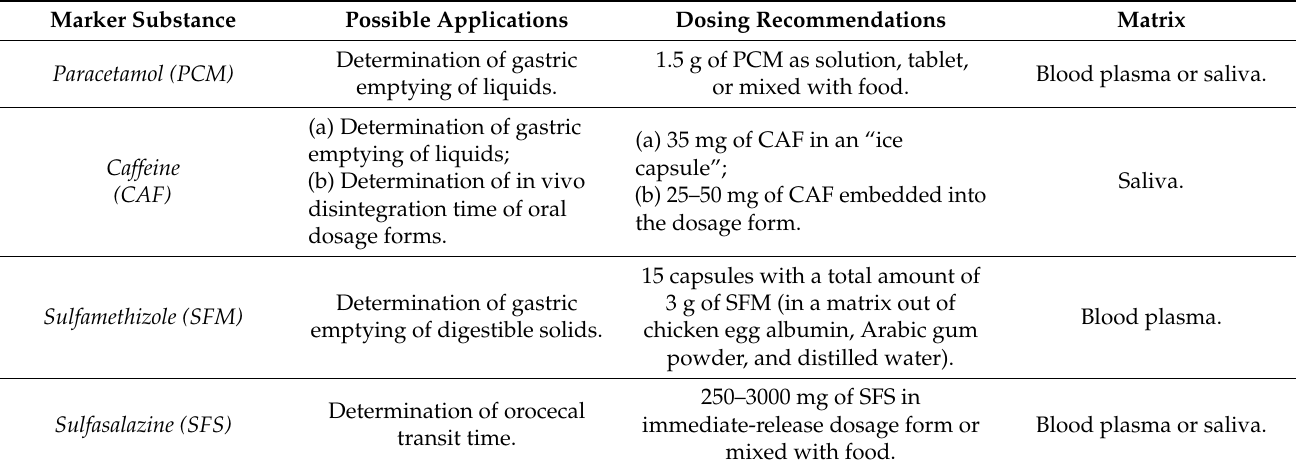
Table 9. Overview of established pharmacokinetic marker substances and their applications. Marker Substance Possible Applications Dosing Recommendations